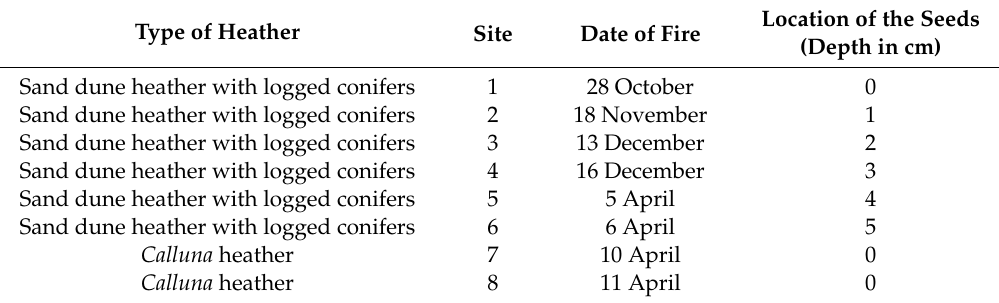
Location of the Seeds (Depth in cm)